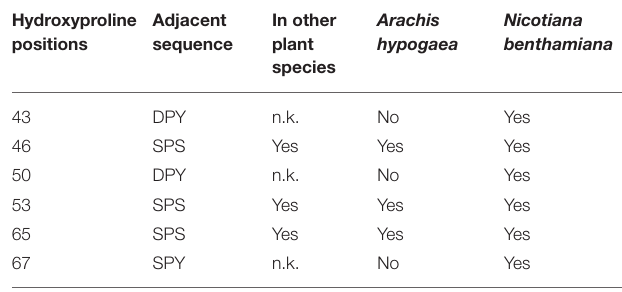
TABLE 2 | Relevant proteins found in the rAra h 2 sample expressed in N. benthamiana leaves, as detected by mass spectrometry. Protein names